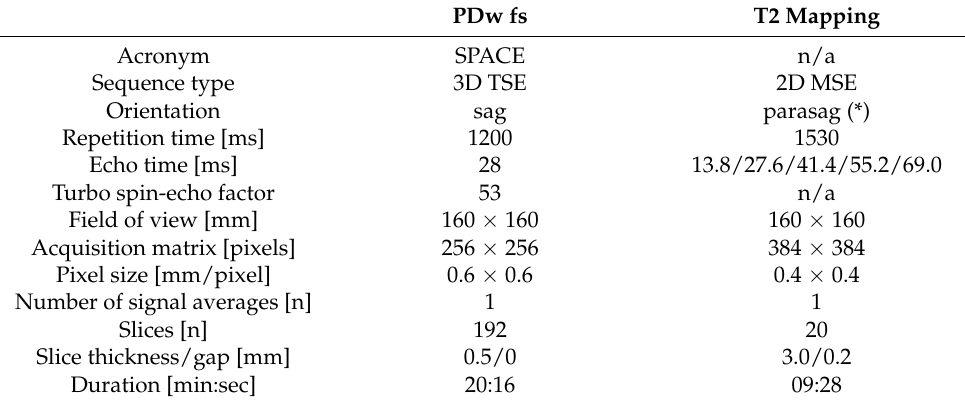
Table 1. Acquisition parameters of the MRI